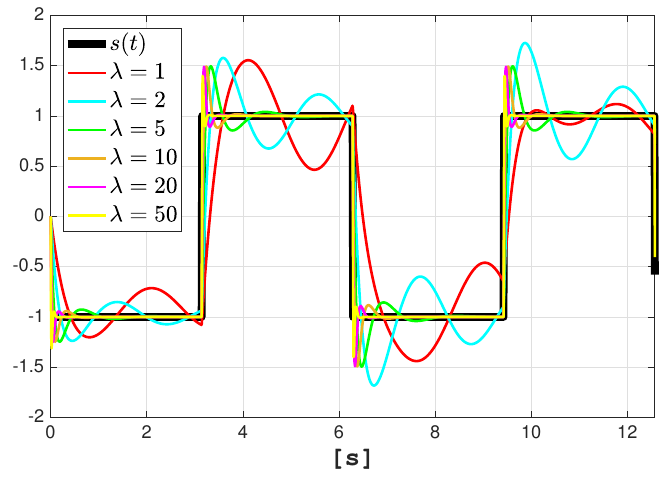
Figure 5. Variations of parameter λ